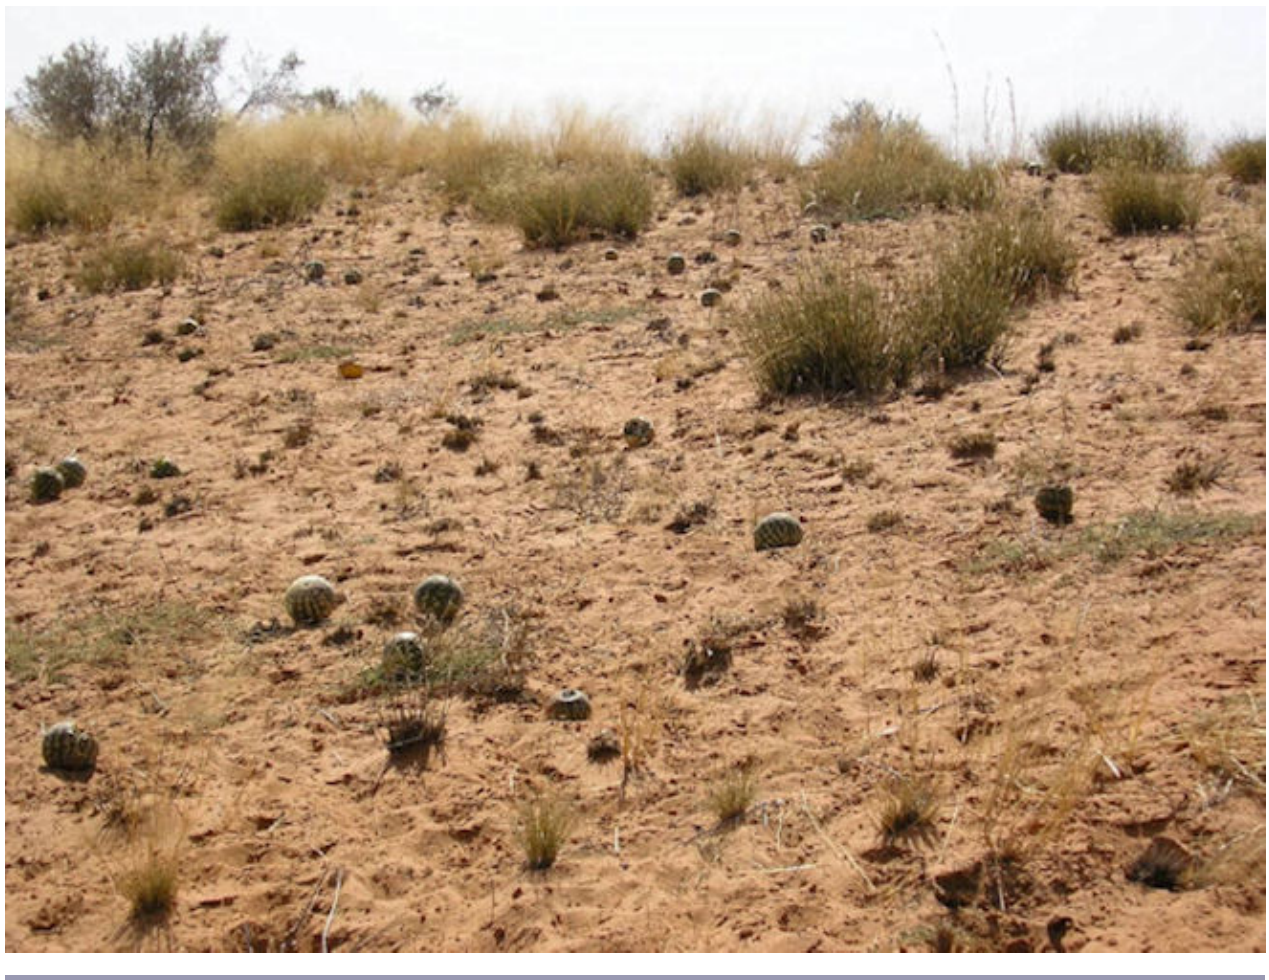
Fig. 5 . Dry season hotspot of water-rich veld fruits ( Citrullus lanatus dominant), 40 km from Khawa settlement, August 2004. Such hotspots are typically positioned in patches that have received repeated localized rainfall